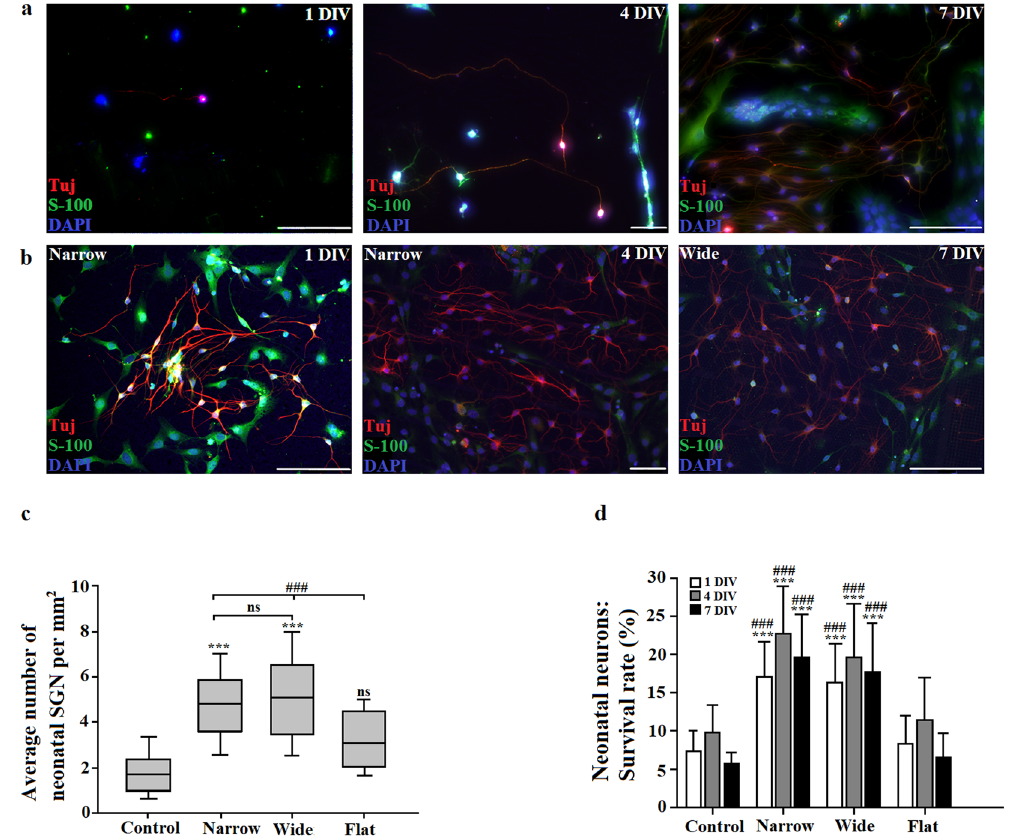
Figure 2. Presence of neonatal SGNs on glass coverslips (control) and CMOS chips. Neurons stained with neuronal marker Tuj + (red/magenta) and the nuclear marker DAPI (blue). Glial cells stained with glial marker S-100 (green) and nuclear marker DAPI (blue). ( a ) SGNs on glass coverslips after 1 DIV, 4 DIV and 7 DIV. ( b ) SGN on CMOS chips after 1 DIV, 4 DIV and 7 DIV. Scale bars: 200 µ m. ( c ) Box and whisker plots showing an effect of CMOS chips on neonatal SGN density. * indicates differences to control: *** P < 0.001 and ns = not significant (one-way ANOVA, Tukey post-hoc test), # indicates differences between area types: ### P < 0.001 for the comparison between Narrow, Wide and Flat areas of the CMOS chip (one-way ANOVA, Tukey post- hoc test). ( d ) Survival rate (%) of neonatal SGN on CMOS substrates and control glass coverslips. * indicates differences to control: *** P < 0.001 (one-way ANOVA, Tukey post-hoc test) and # indicates differences of Narrow and Wide areas to Flat areas of the CMOS chip: ### P < 0.001 (one-way ANOVA, Tukey post-hoc